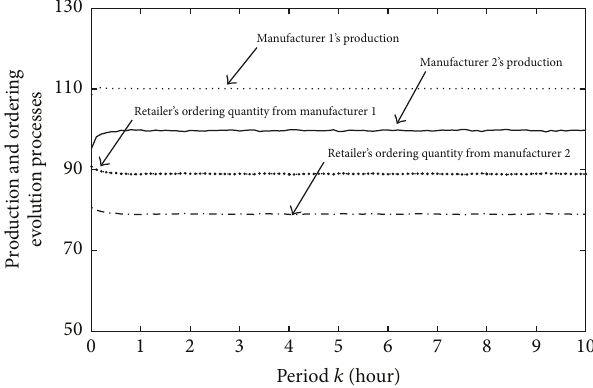
Figure 4: Evolution processes of productions and ordering quanti- ties with cost optimization strategy ( ×10 3 pairs).